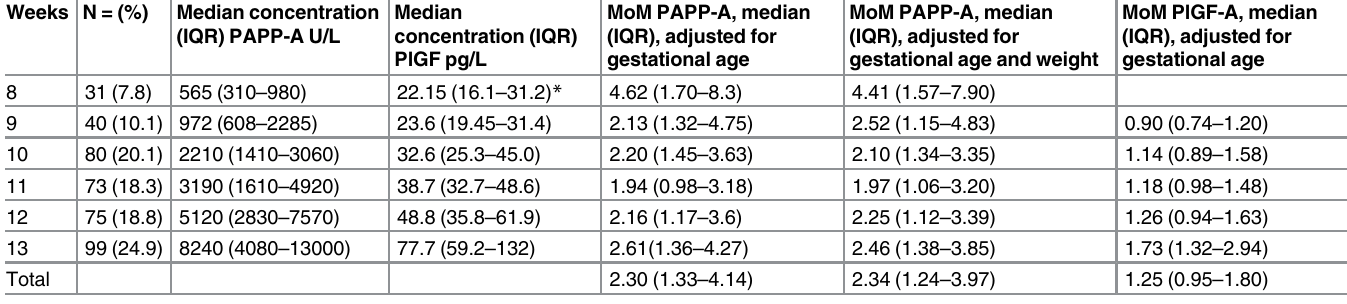
Table 2. Median and interquartile range of concentration and MoM of PAPP-A and PlGF by gestational week (n = 398). Weeks N =